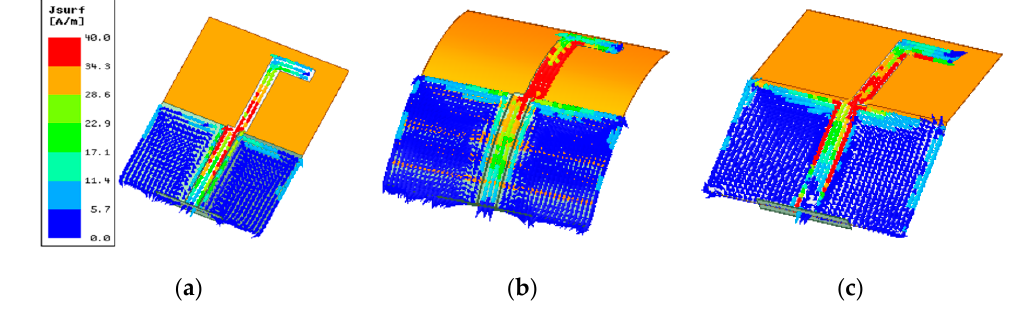
Figure 5. Diagrams of surface current. ( a ) Flat. ( b ) Bent. ( c ) Folded.